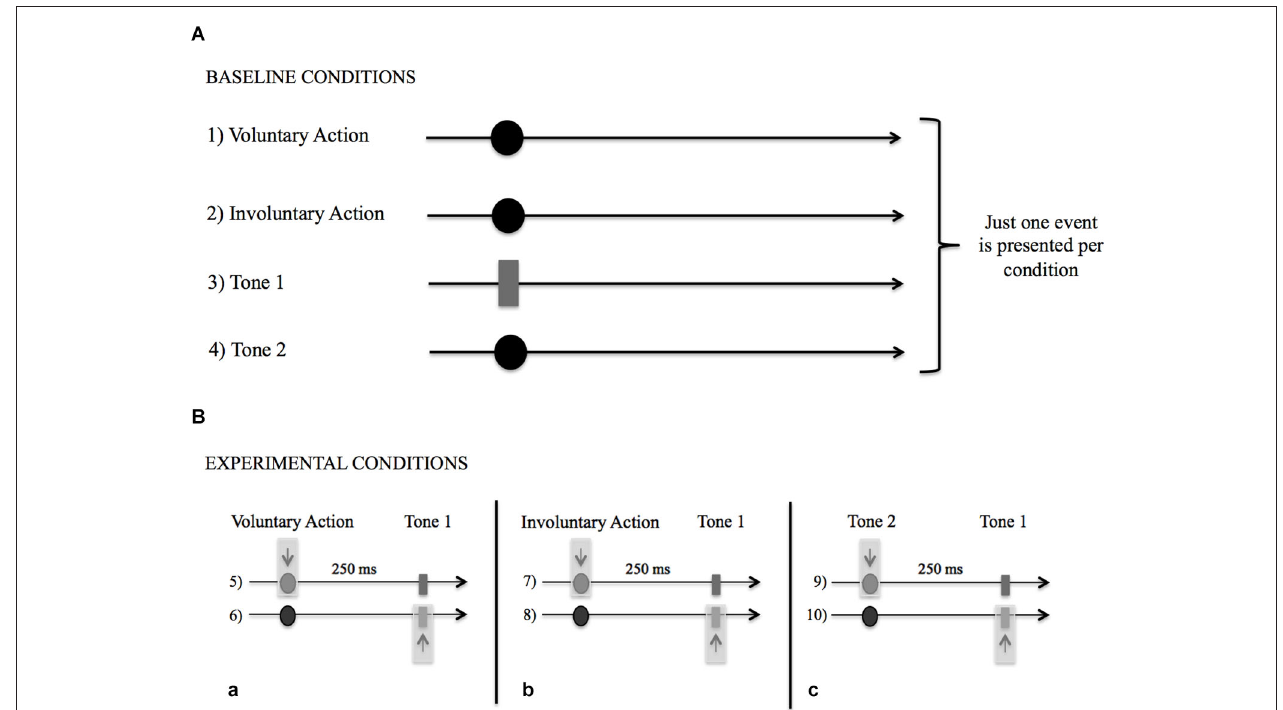
FIGURE 2 | (A) Schematic representation of the Baseline Conditions (BCs) in which only one event (Voluntary Action, Involuntary Action, Tone 1, Tone 2) occurred per condition. While viewing the stream of numbers and letters participants had to remember which